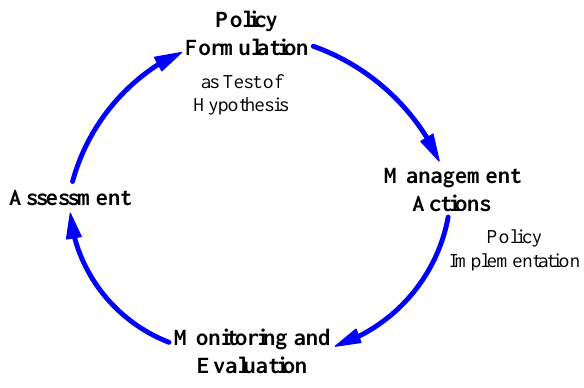
Figure 1: Adaptive management process as a structured learning cycle that iteratively links four phases: starting from assessment, through policy formulation to implementation, and monitoring used as an input for the assessment phase in the next